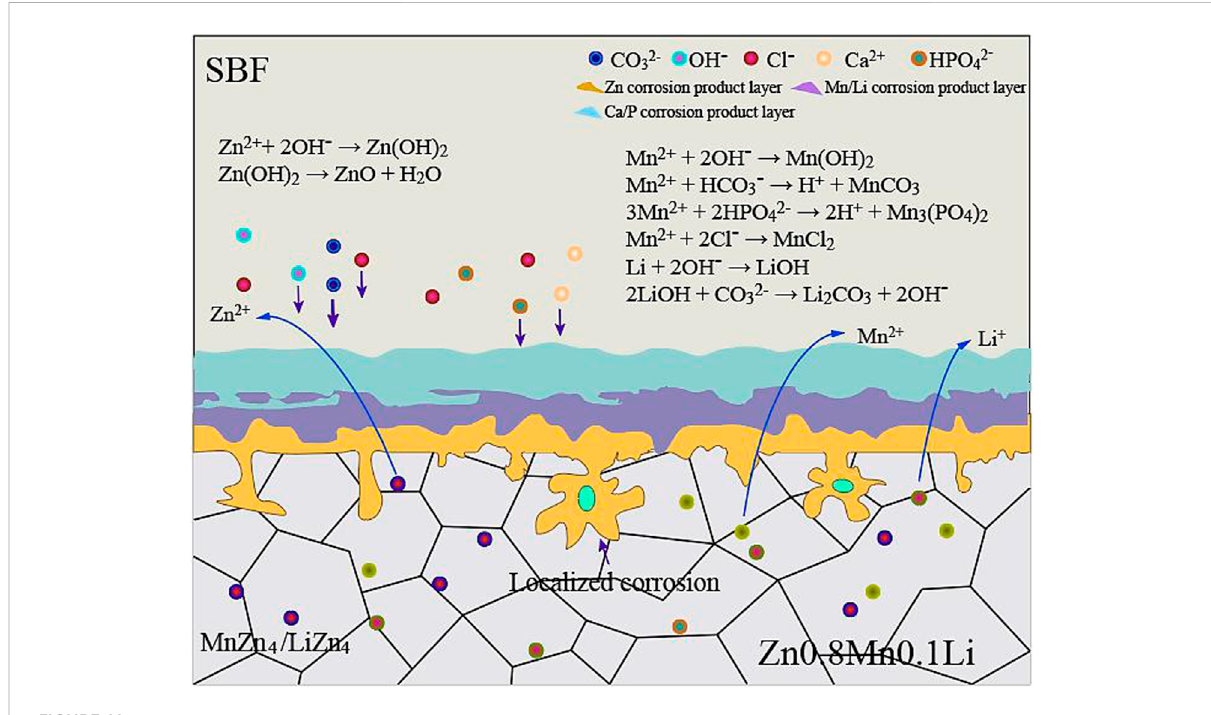
FIGURE 11 Corrosion mechanism diagram of Zn0.8Mn0.1Li alloy in